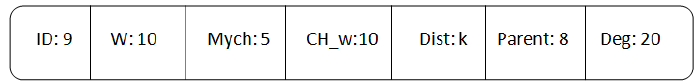
Figure 3. Example of Local State Values ( LSV )